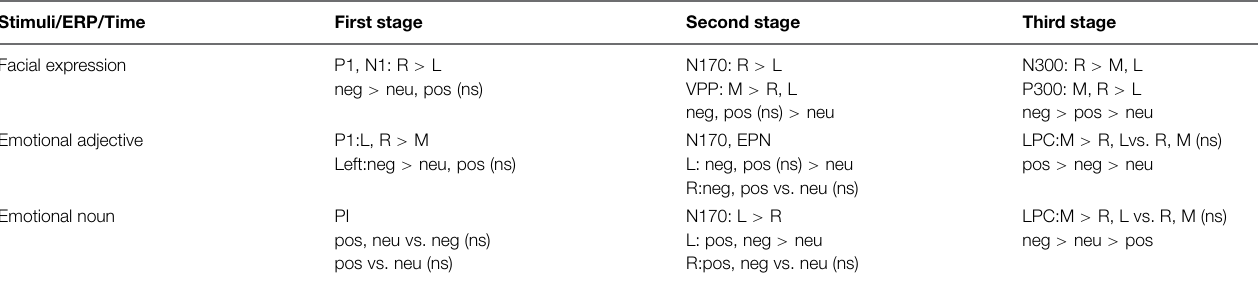
TABLE 1 | Summary of